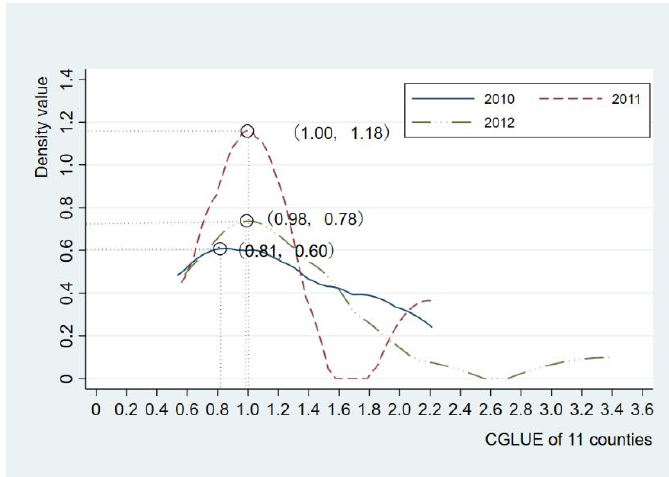
Figure 8. Efficiency kernel density curve from 2010 to 2012.